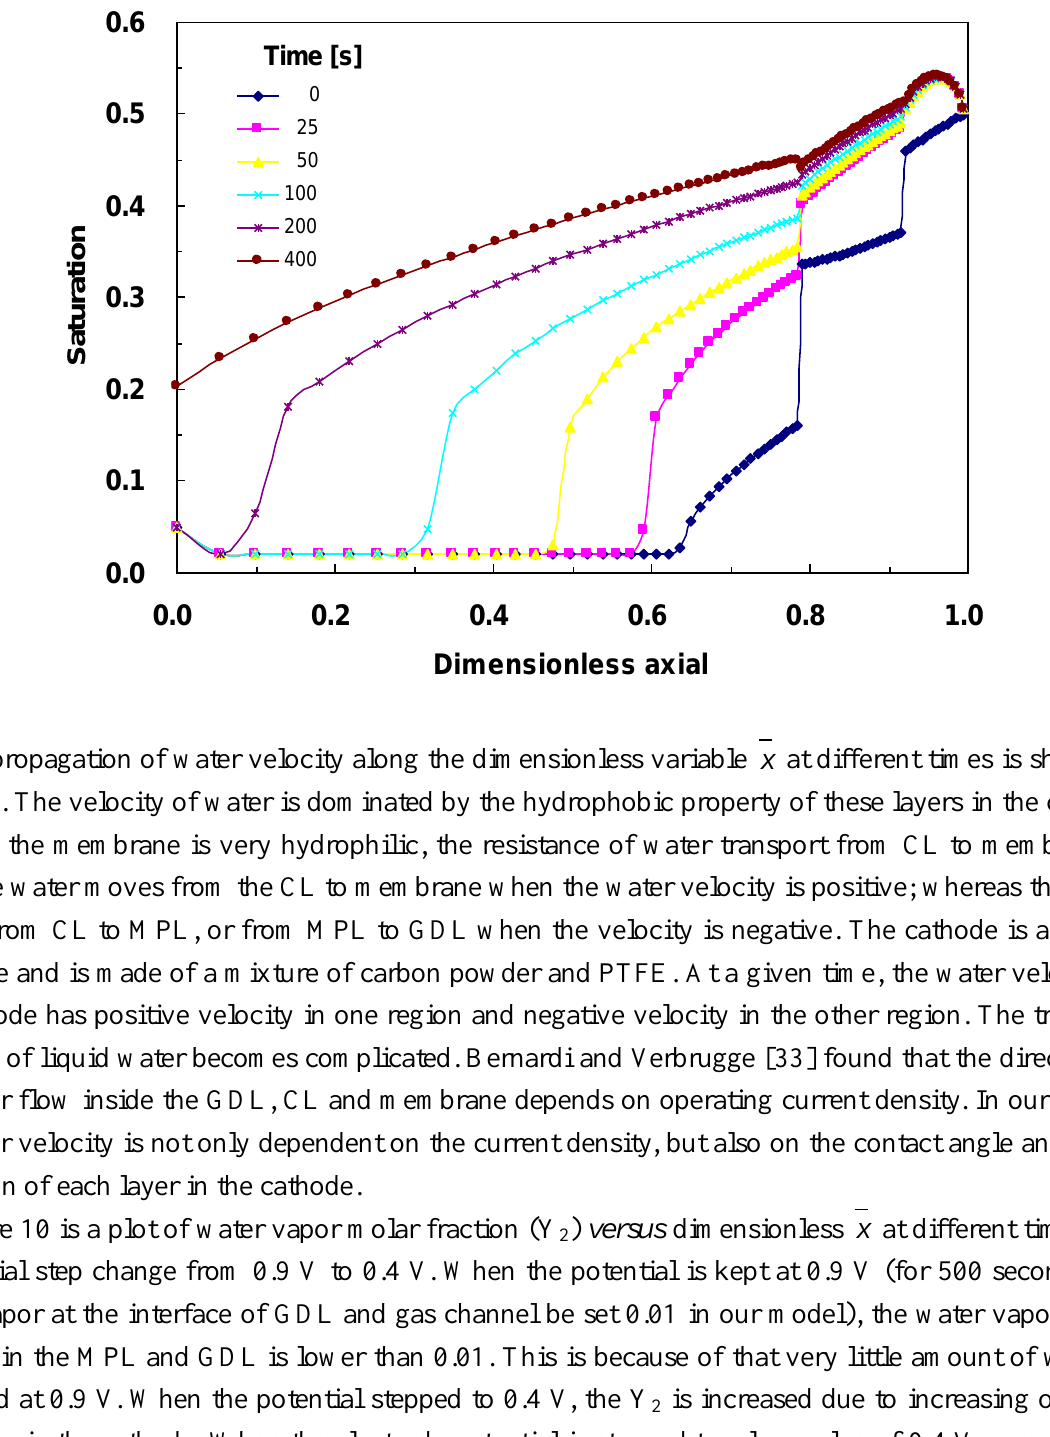
Figure 8. Distribution profile of water saturation during a step change of potential from 0.9 V to 0.4